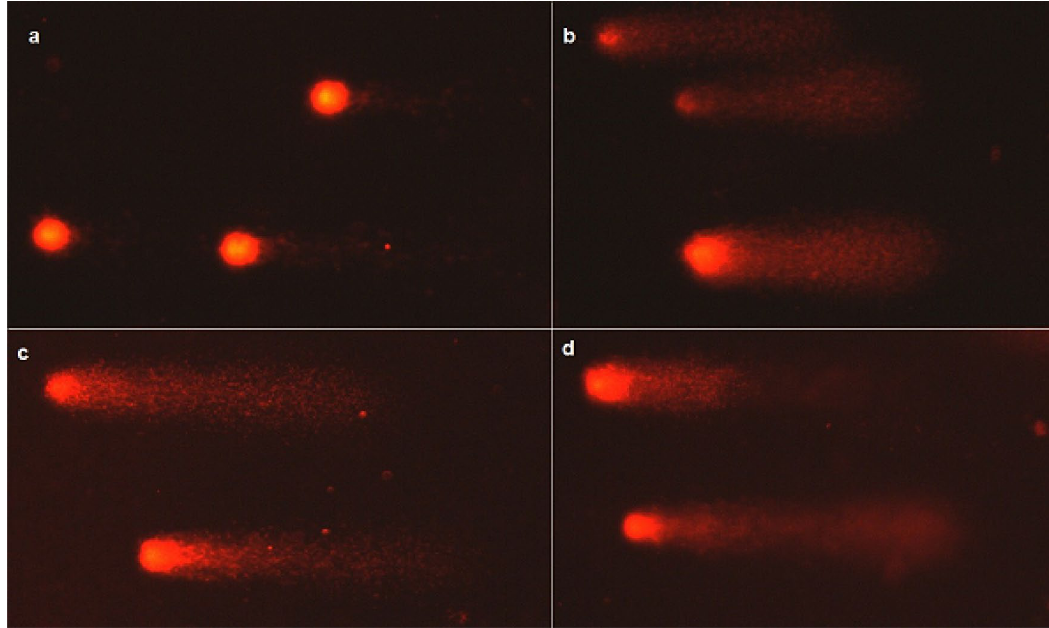
Figure 2. Bone marrow cells of Chinchilla lanigera with different levels of DNA damage in the comet assay: ( a ) cells from control sample; ( b ) cells after exposure 6 h for AgNP 10 µg/L; ( c ) cells after exposure 6 h for AgNP + C 10 µg/L; ( d ) cells after exposure 6 h for AgNO 3 10 µg/L. 400 × magnification.